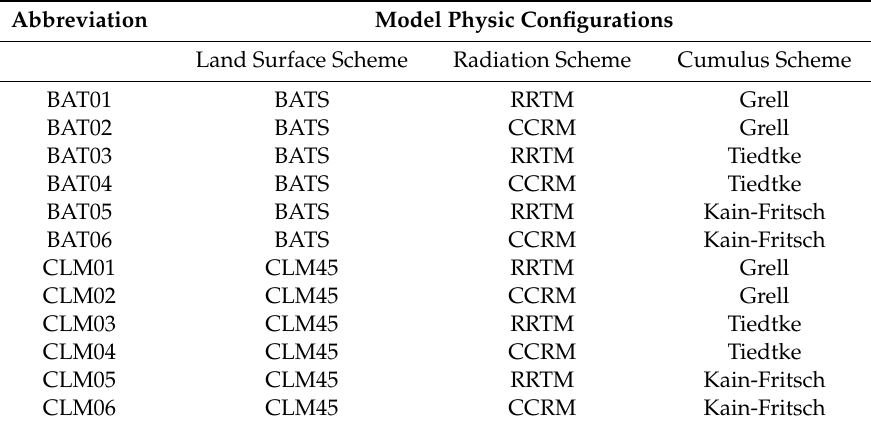
Table 1. Experimental